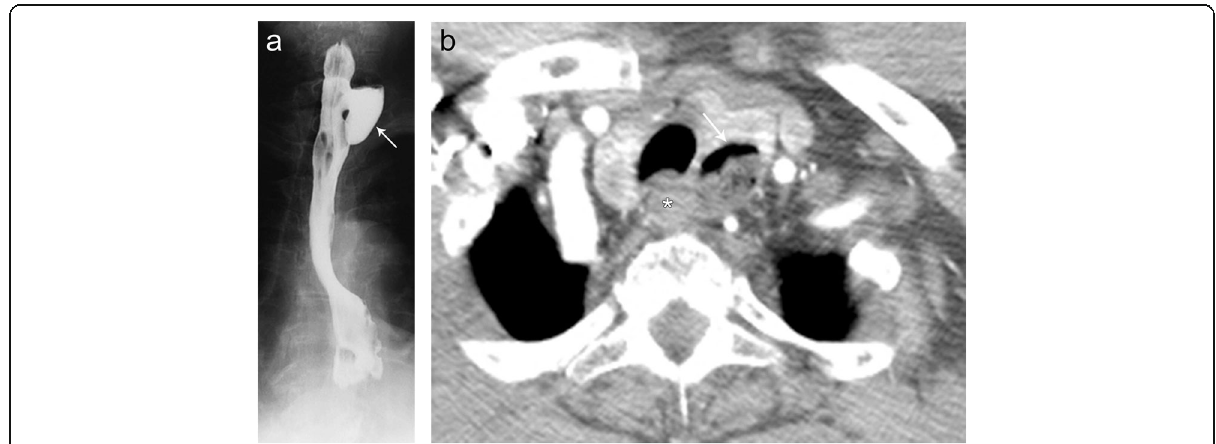
Fig. 14 Killian-Jamieson diverticulum. Frontal ( a ) fluoroscopic images from an esophagram demonstrate a focal outpouching of the anterolateral aspect of the esophagus containing an air-fluid level consistent with a Killian-Jamieson diverticulum. These lesions are rarely bilateral and are typically smaller than a Zenker diverticulum (<1.5cm). Coronal ( b ) CT image from the same patient demonstrates air and oral contents (arrow) within the Killian-Jamieson diverticulum arising from the anterolateral aspect of the esophagus (asterisk)